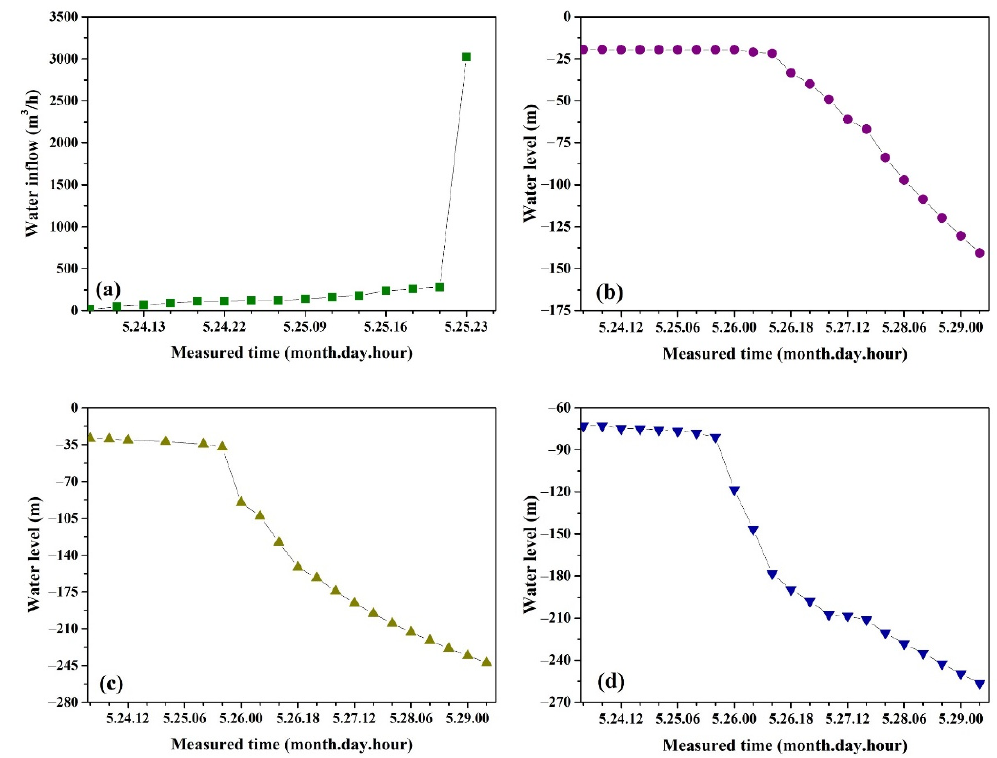
Figure 6. Curve map of water inflow and water level of the Ordovician limestone aquifers. ( a ) water inflow; ( b ) water level of Water II-1 hole; ( c ) water level of VI West-O 2 hole; ( d ) water level of VI West-O 2 hole.